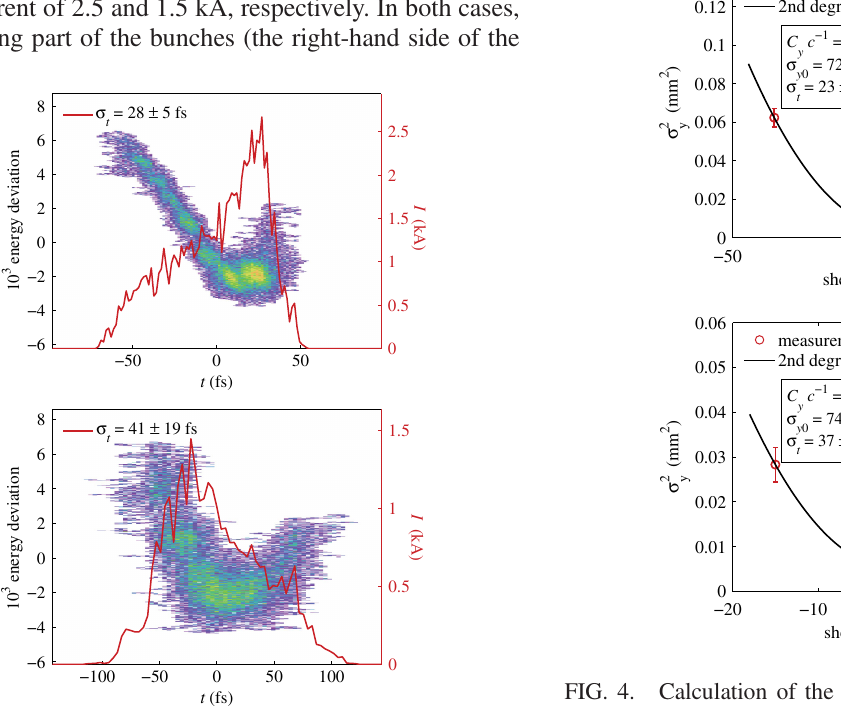
FIG. 3. Single-shot longitudinal phase space measurements for the two runs at 13.5 (upper figure) and 24 nm (lower figure). The rms bunch lengths shown are calculated without corrections of the longitudinal-to-vertical correlation and the intrinsic vertical beam size. The projection onto the time axis gives the current profile of the electron bunch, shown in red.